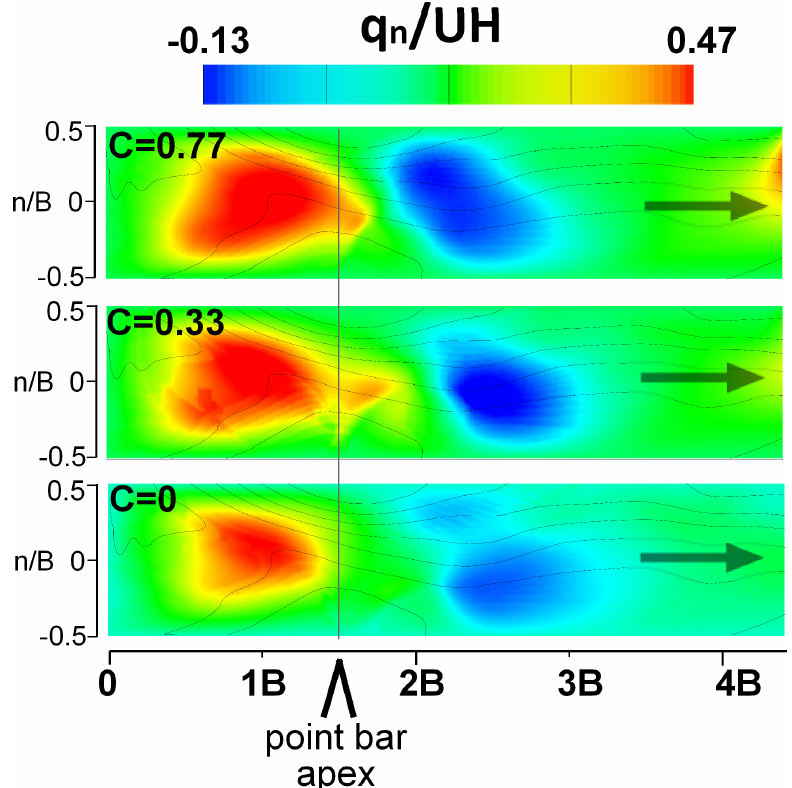
Figure 5. Transverse unit discharge q n / UH for channel curvature C = 0.77, 0.33, and 0 conditions.